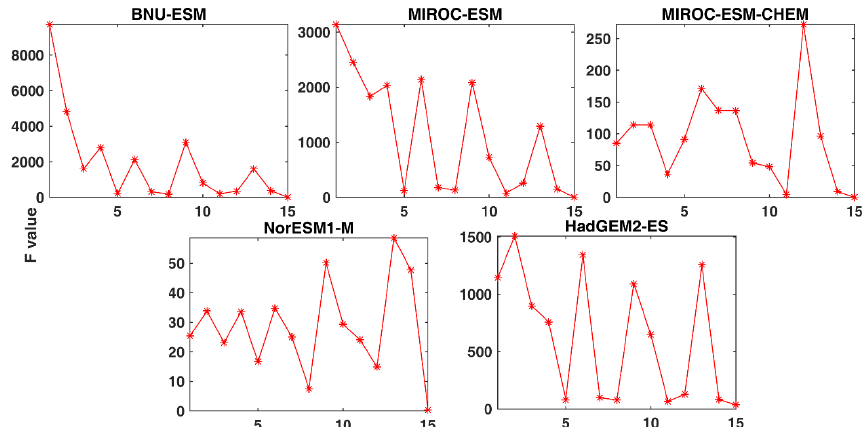
Figure 6. The F statistic of the 15 different combinations of regression variables for GPI differences between G4 and RCP4.5. The x axis on each panel represents the combination of components used as predictors in each regression equation: 1 – PI, RH, WS, and AV; 2 – PI, RH, and WS; 3 – PI, RH, and AV; 4 – AV, RH, and WS; 5 – PI, AV, and WS; 6 – PI and RH; 7 – PI and WS; 8 – PI and AV; 9 – RH and WS; 10 –